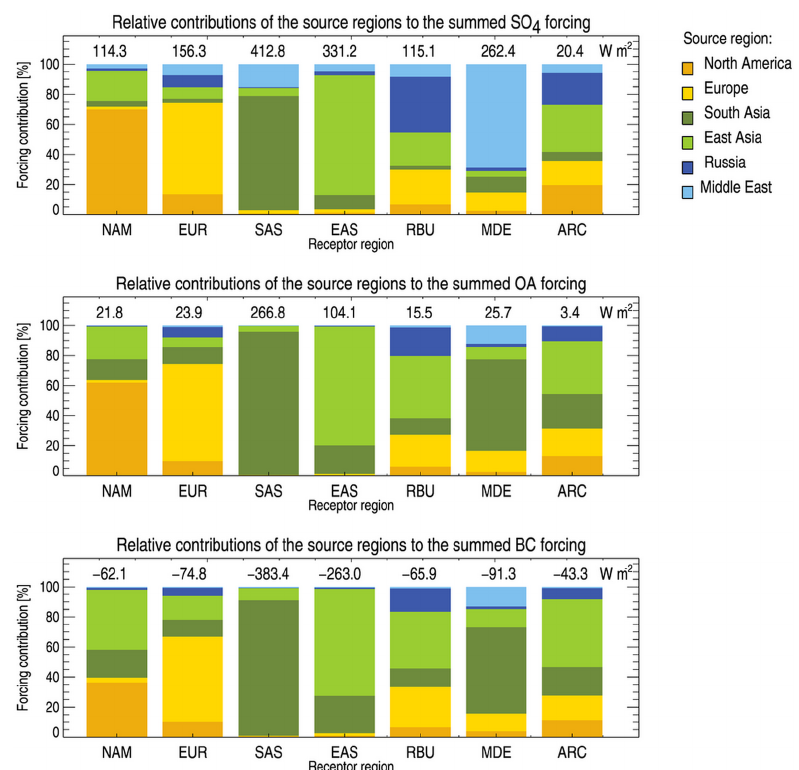
Figure 10. Relative contributions of the individual source regions (colors on the bars) to the summed forcing, averaged over each of the receptor regions (given on the x axis and seen in Fig. 1a). The summed forcing that the given receptor region experiences due to emission- reductions in the six source regions is given in numbers above each